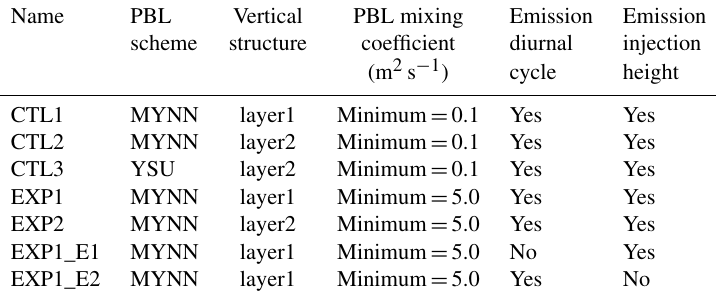
Table 1. Numerical experiments conducted in this study.